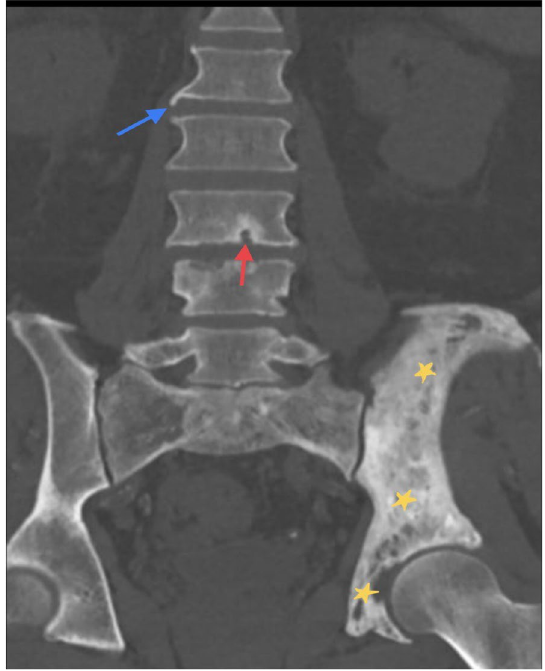
Fig. 2 Coronal plane bone window MDCT shows classical features of PDB in left-side pelvic bones (yellow stars) sparing the proximal femora and hip joints. Spinal degenerative changes in terms of osteophytes (blue arrow) and Schmorl’s nodule (red